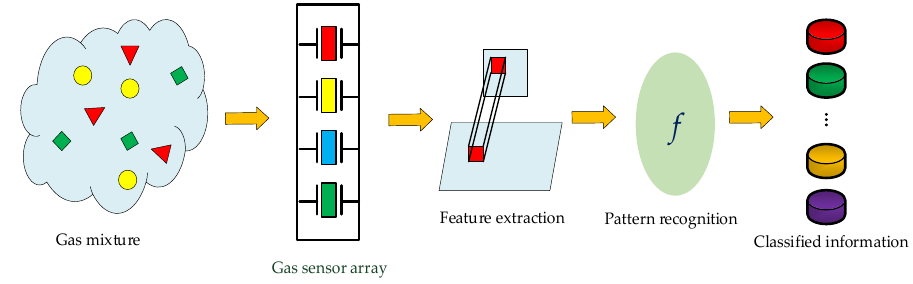
Figure 1. The frame diagram of EN.